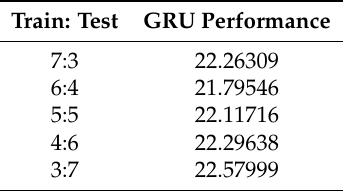
Table 5. Training sample size comparison.